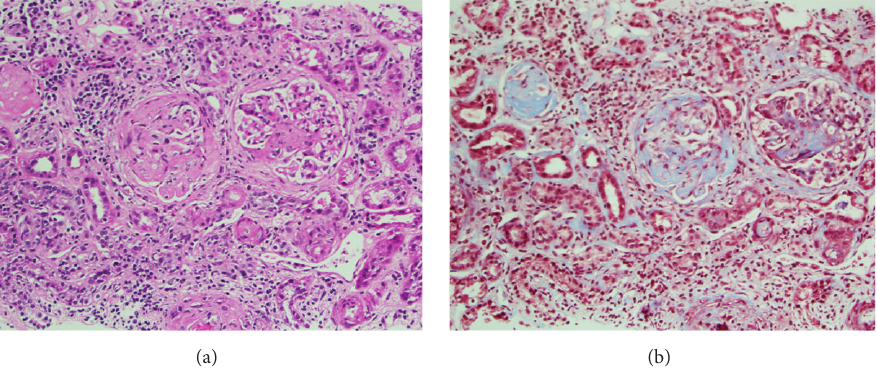
Figure 2: Renal biopsy revealing crescentic glomerulonephritis (GN) pauci-immune type suggestive of MPO. H&E stain and trichrome stain.